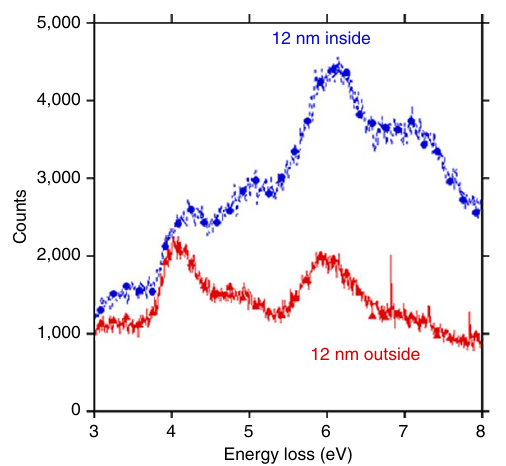
Figure 3 | Ultraviolet region spectra with the beam inside and outside the sample. Comparison of EEL spectra of the ultraviolet region, taken with probe 12nm inside and 12nm outside the sample in the vacuum region. The spectrum with the probe outside the specimen lacks the high-energy features at B 7eV that are believed to be responsible for ionization. The ratio of the peaks at 4 and 6eV changes when moving from outside to inside the specimen, since lower-energy peaks can be excited at greater distance from the specimen